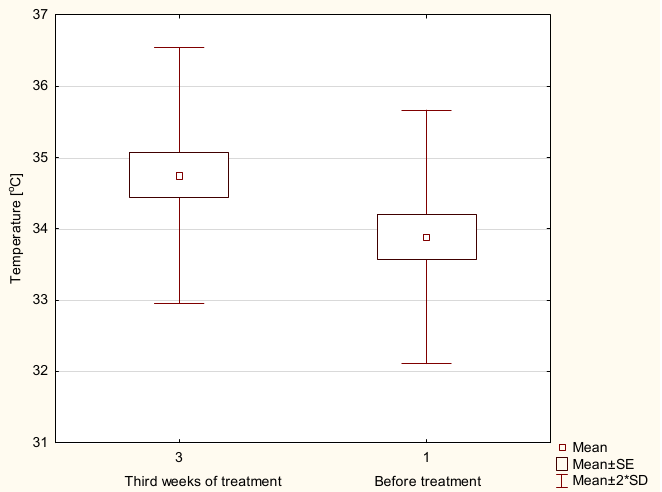
Figure 3. The temperature differences in target areas between the third week during the radiotherapy and before the treatment.